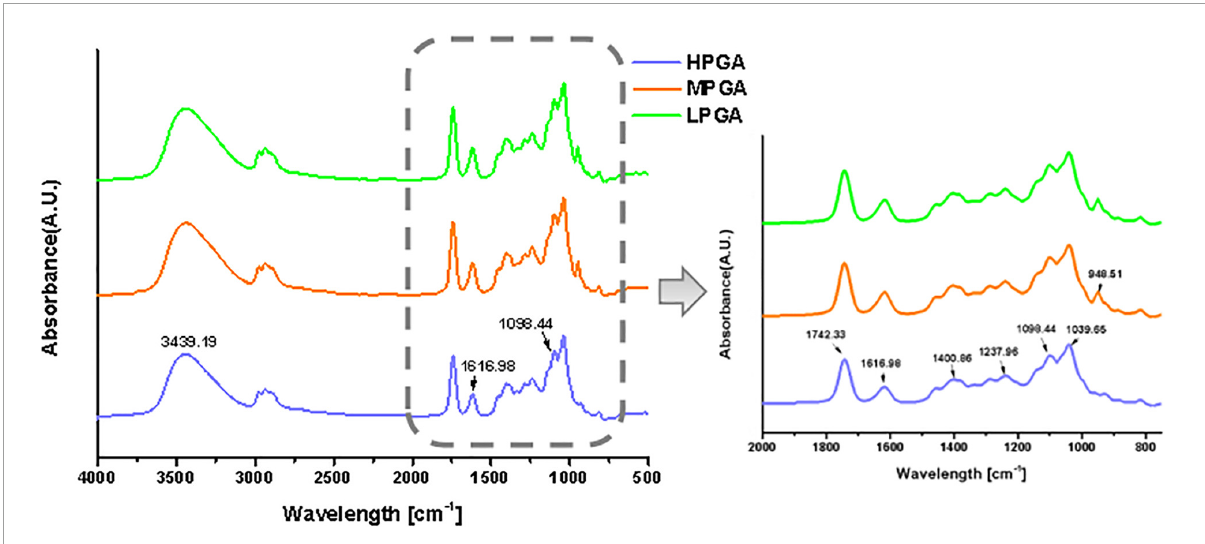
FIGURE3 FTIR spectra of PGA molecules with different M